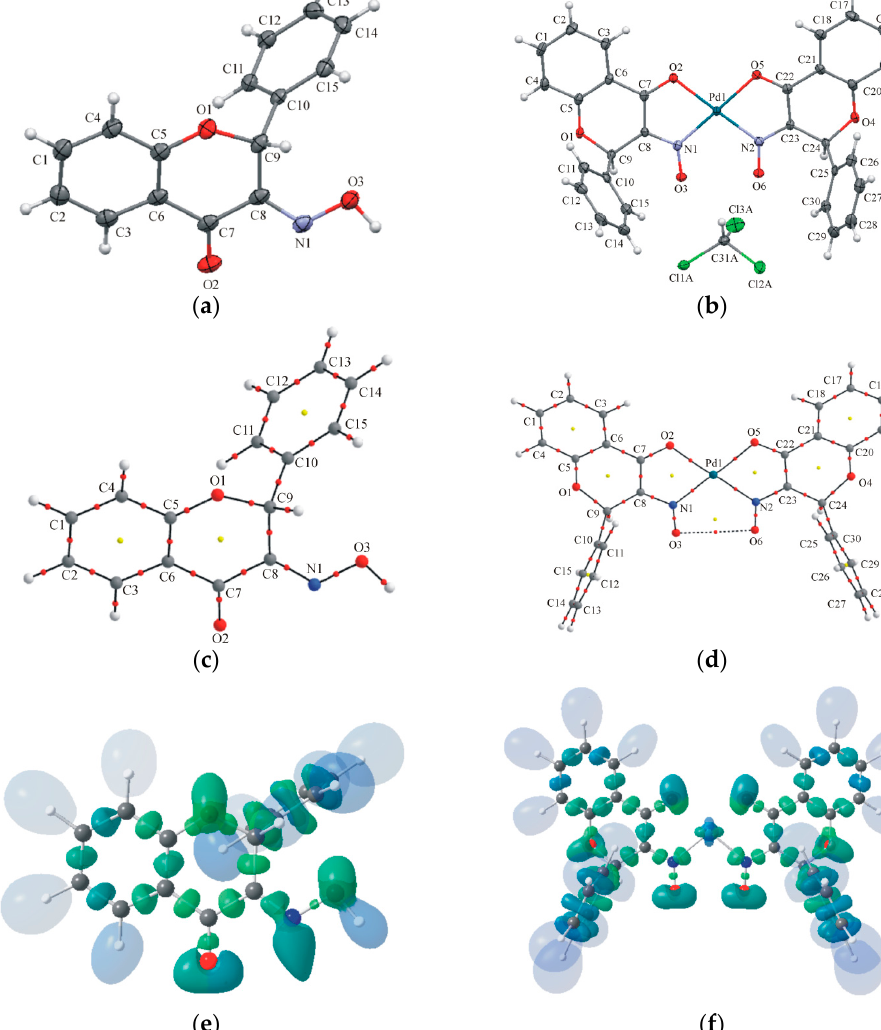
Figure 1. Molecular structures of 1 ( a ) and 2 ( b ) (both IAM models) showing 50% probability ellipsoids and the crystallographic numbering schemes ( MERCURY [14] representation). Only the major component ( A ) of the disordered solvent molecule is shown. AIM-molecular graphs of XWR (X-ray wavefunction refinement)-model ( 1 ) ( c ) and OPT-model ( 2 ) ( d ); bond critical points are given as small red dots, and ring critical points are shown as small yellow dots. Isosurface representation of the localization domains of the ELI-D (an isovalue of Y = 1.40) of XWR-model ( 1 ) ( e ) and OPT-model ( 2 ) ( f ). Transparent mode of the protonated monosynaptic valence basins (hydrogen basins) is applied for clarity reasons.